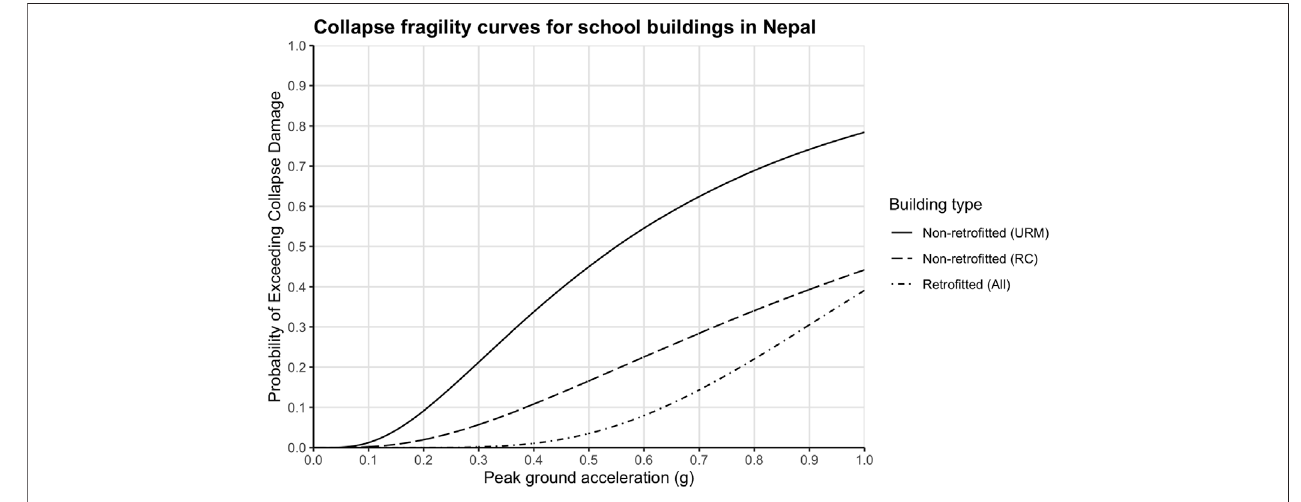
FIGURE 3 | Collapse fragility curves adopted in the